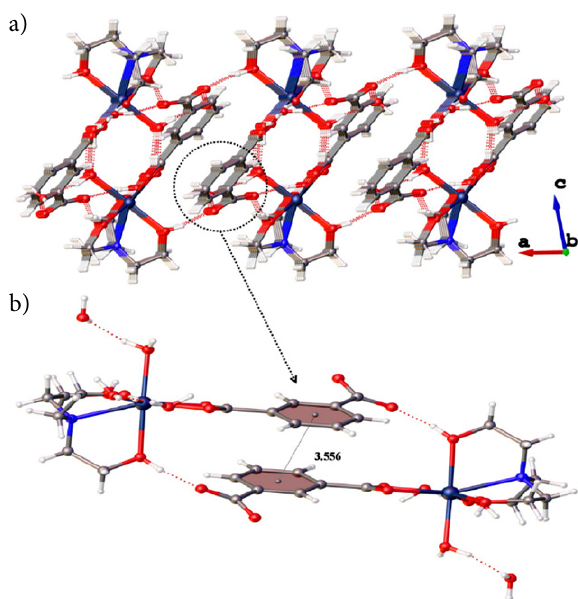
Figure 2. Part of the crystal structure of [Cd(IsoPht)(TEA) H 2 O]·3H 2 O, showing the formation of R 32 (8), and R 44 (20) rings by the O-H∙∙∙O hydrogen bonds